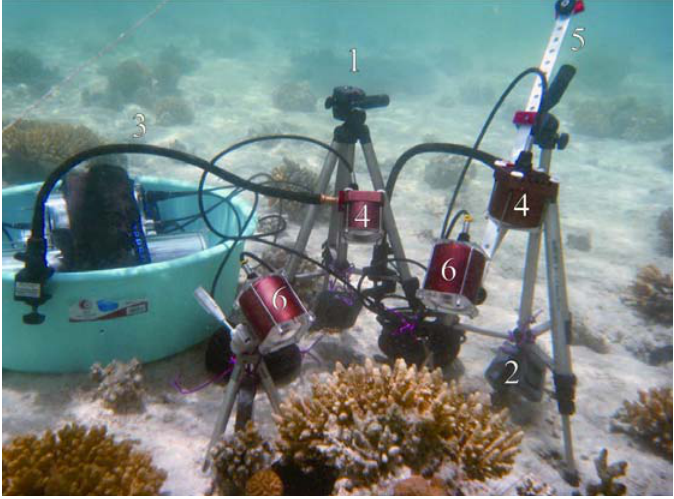
Figure 4. Symbolic underwater image of the video system. Tripods with a 3-way-pan-tilt head (1) and fixed diving weights (2) provide a stable and easy setup of cameras under water, while gooseneck stands (3) orientate the infrared-lights (4). To facilitate alignment of camera distances and for recordings in bird’s eye view, flat aluminum bars (approx. 50 × 1 × 0.5 cm) perforated with 1/4 ″ holes (5) are used as extensions between cameras (6) and